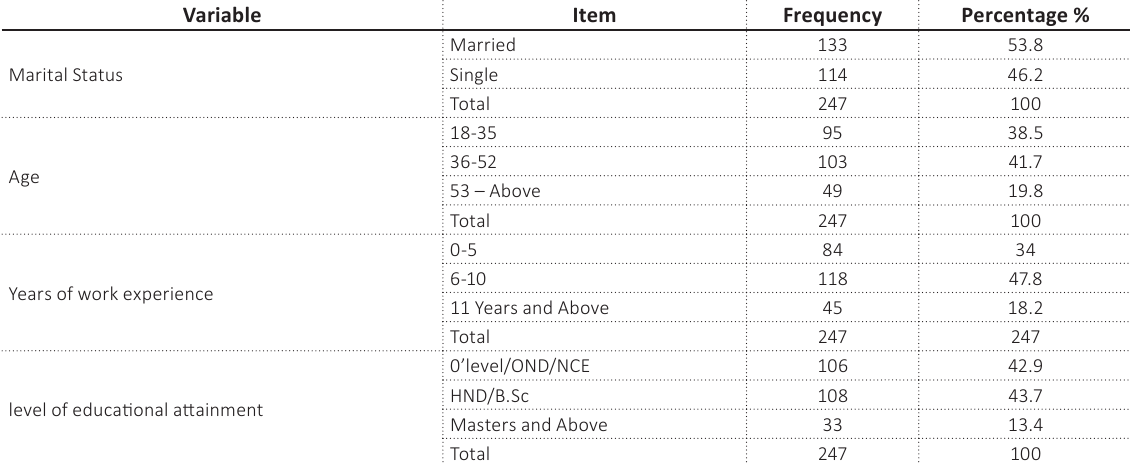
Source: Field Data,